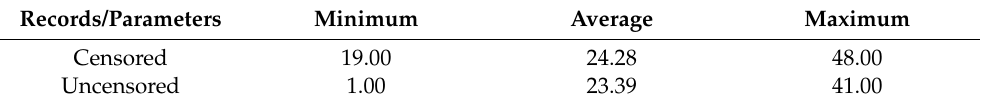
Table 4. The minimum, average and maximum life of censored and uncensored individuals (week). Records/Parameters